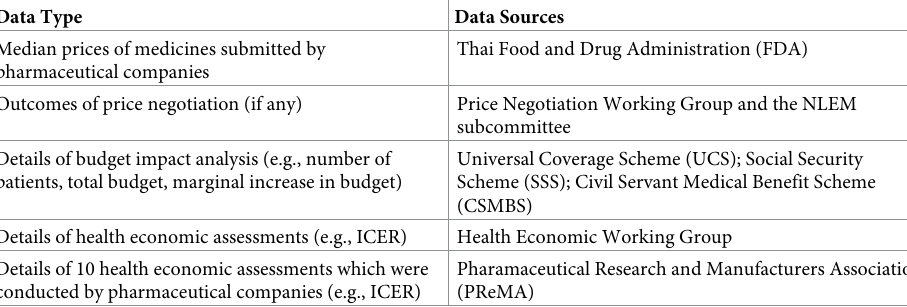
Table 2. Summary of data types and